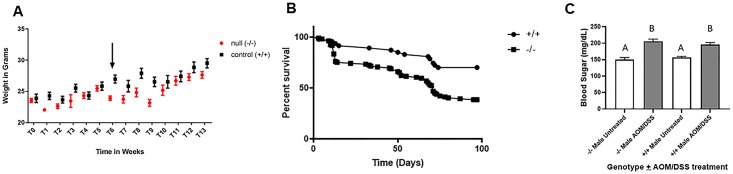
AOM/DSS-treatment effects.A. Comparative weight loss as surrogate marker for morbidity. Hltf-deleted designated null -/- (n = 23) and control +/+ (n = 17) mice were weighed on the first (T0) and last weeks (T13) and at 7-day intervals during the treatment protocol. One-way ANOVA (p <0.00001) with Tukey’s multiple comparison test was performed to determine statistical significance. *p <0.05. The first significant weight loss occurred in Hltf-deleted mice at treatment week 6 (arrow). B. Kaplan-Meier survival plot. Comparison of the cumulative survival curve of male Hltf-deleted (n = 109) and control (n = 47) mice indicated differential survival times for Hltf-deleted vs control AOM/DSS-treated mice. C. Blood glucose levels in non-fasting adult male mice. Blood glucose levels were normal for untreated Hltf-deleted vs control, and elevated to the same extent in both groups by AOM/DSS-treatment. In panels A and C, values are mean±SEM. Values with the same letter designation in panel C are not significantly different.